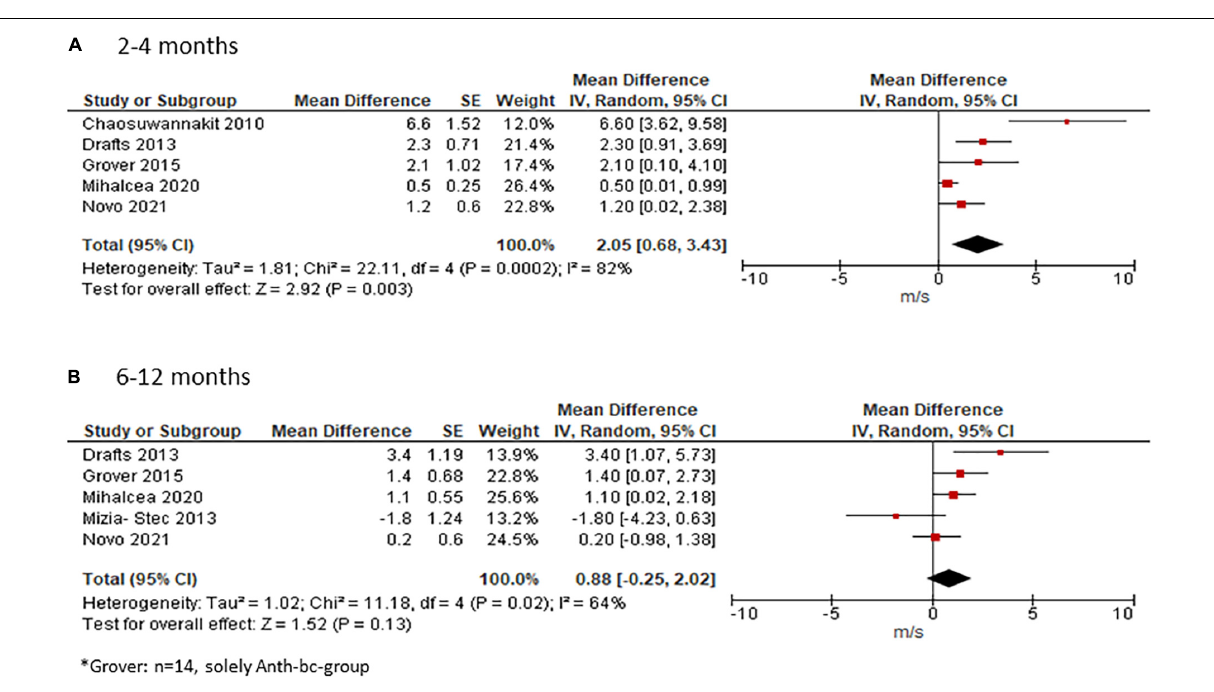
without clinical CVD (mean age 61 ± 10 years) (23), patients to twofold increased risk (38, 41) for CV